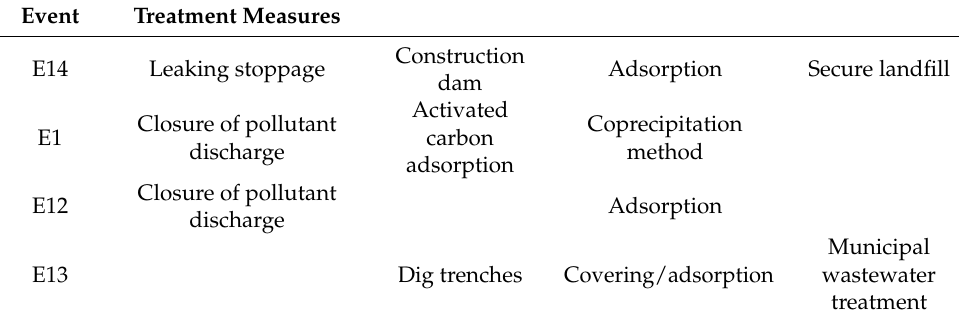
Table 4. Treatment measures of corresponding